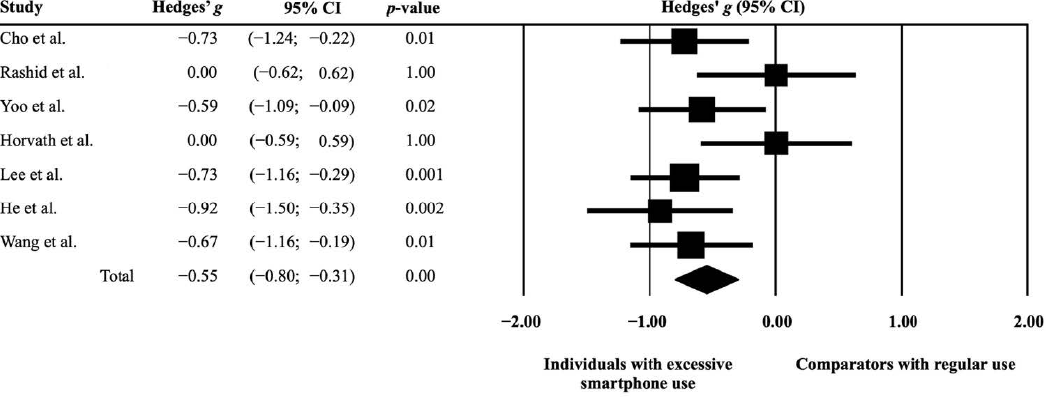
Formatted: Snap to grid